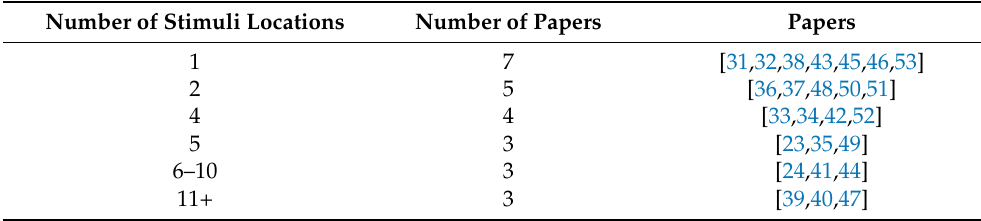
Table 4. Papers categorized by the number of places where the stimuli were applied.